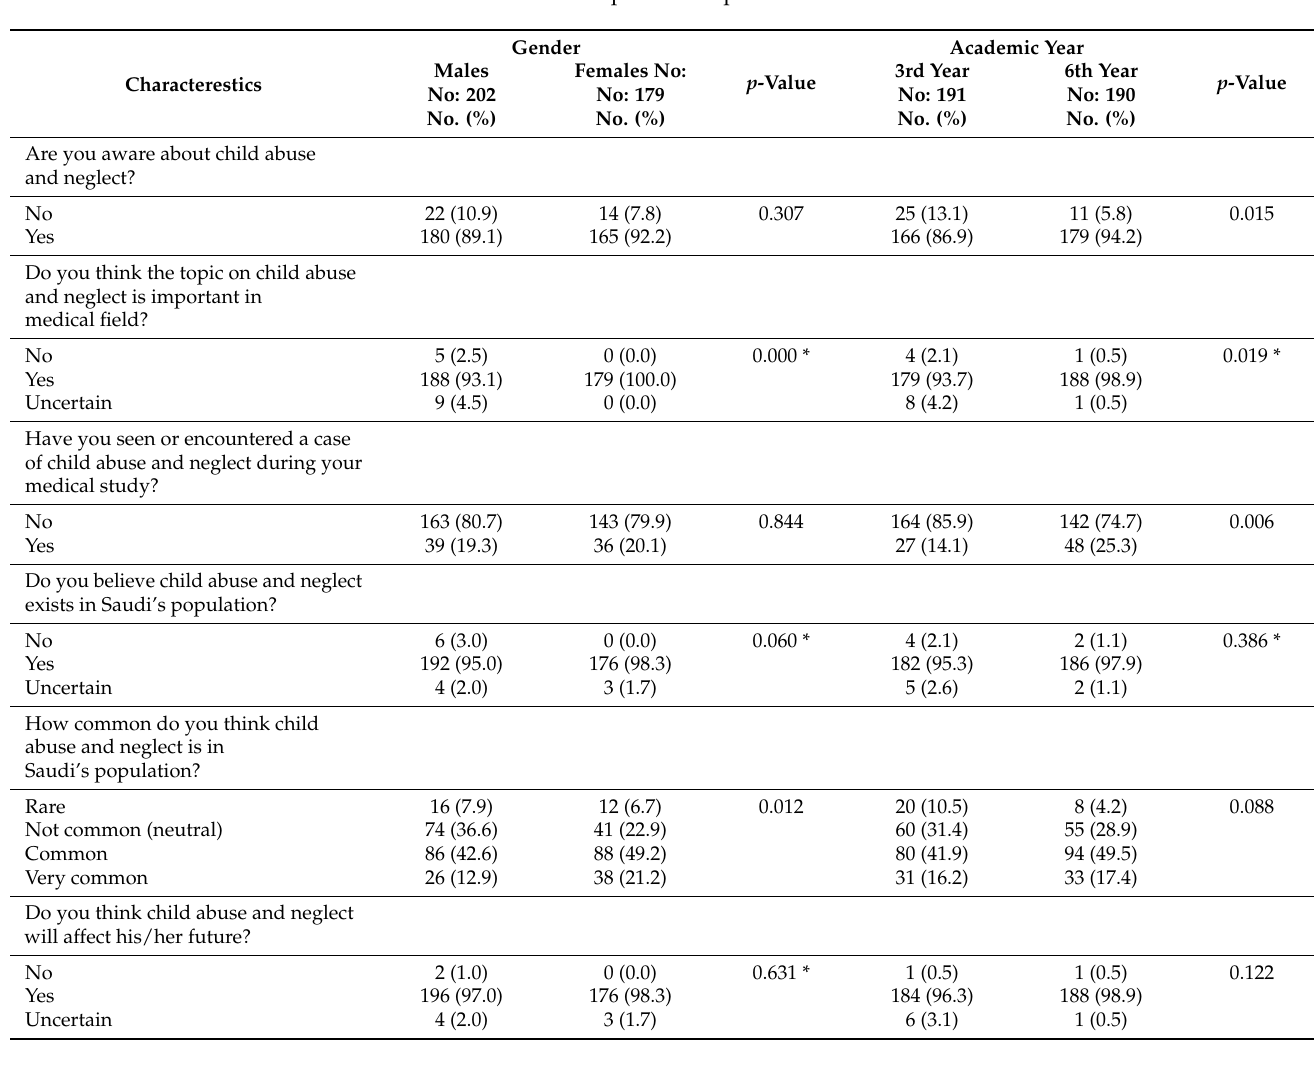
Table 5. Academic Year Response